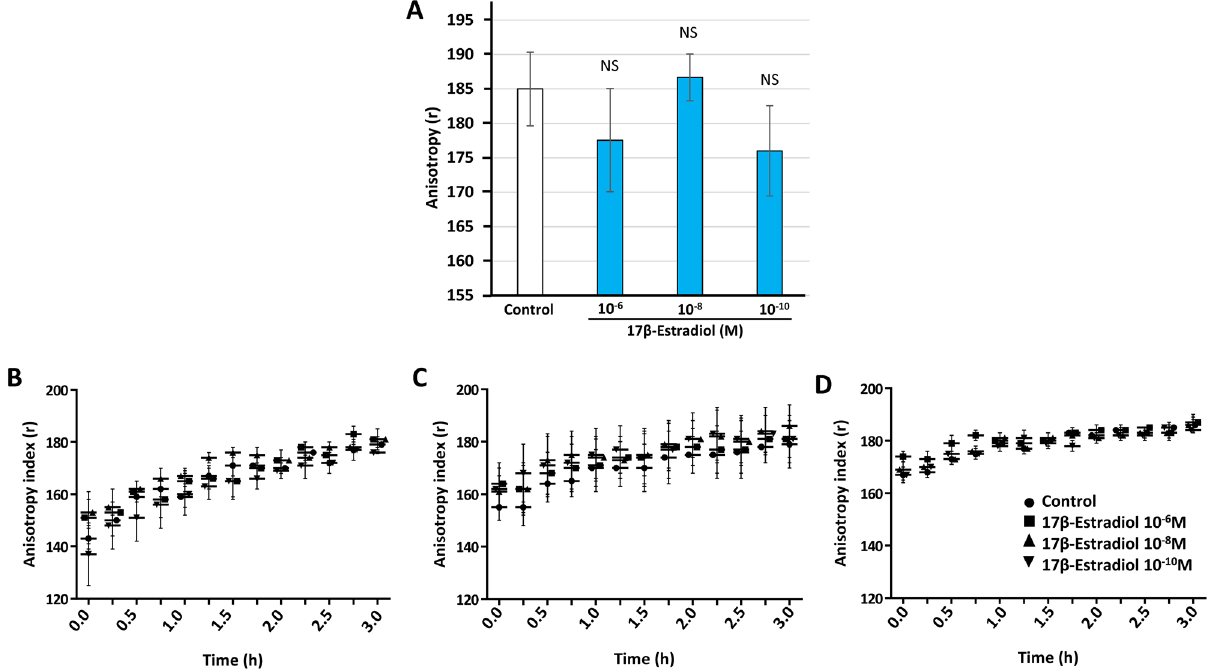
Figure 5. Effect of 17β-estradiol on Lactobacillus crispatus V4 membrane fluidity. ( A ) Membrane fluidity (anisotropy index) of L. crispatus V4 grown for 18 h in the absence (control) or presence of 17β-estradiol (10 –6 , 10 –8 , or 10 –10 M). ( B – D ) Membrane fluidity (anisotropy index) of L. crispatus V4 exposed to 17β-estradiol (10 –6 , 10 –8 , or 10 –10 M) after prior growth in MRS for ( B ) 6 h, ( C ) 12 h, or ( D ) 24 h. Values and curves are the means ± SEM of three independent studies ( NS not significant).